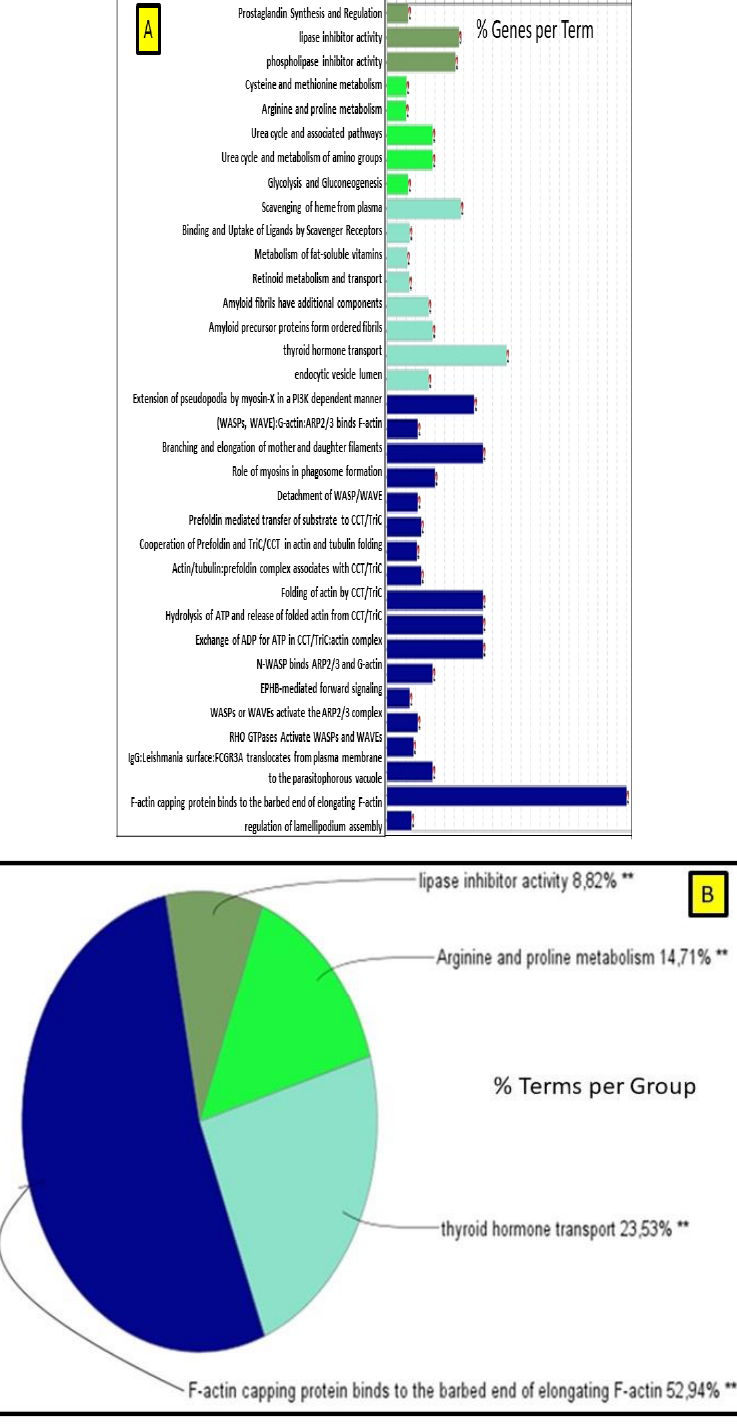
Figure 7. Identification of GO term organisation associated with DEPs using Cytoscape ClueGO TM . The differentially associated gene ontology terms were shown with different colours. The dark green denoted lipase inhibitor activity: The bright green denoted arginine and proline metabolism: The blue-green denoted thyroid hormone transport. The blue de- noted the F-actin pathway. Terms within each group were coloured similarly. The number and percentage of contributing genes for each term can be inferred in the bar diagram 6 ( A ) and pie diagram 6 ( B ). The asterisk indicates the significance of the related terms and groups based on corrected p -values. The p -value < 0.001 was assigned with ** and Kappa score equal to 0.43. rotate labels in figure 2.3. Validation of Identified Uterine Endometrial DEPs during the Preimplantation and Peri- implantation Period To validate our DEPs results, ANXA4 and HP proteins were selected for further anal- ysis using western blot (Figure 8 and Supplementary Table S2). Similar to the proteomics data, the western blot validation experiment indicated that ANXA4 and HP abundance increased in pregnant endometrium during 9D to 16D of early pregnancy. Statistical anal- ysis of the validation experiment (Figure 9) revealed that changes in the protein levels of ANXA4 and HP proteins relative to the GAPDH loading control were statistically signif- icant ( p ≤ 0.05).